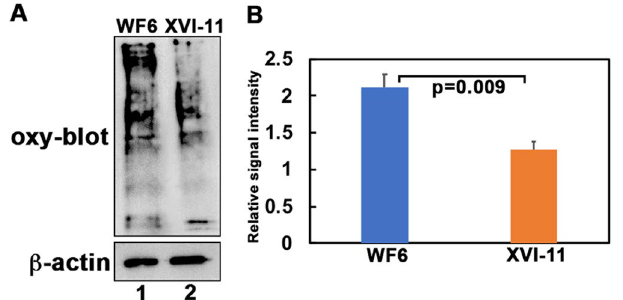
Figure 4. Oxidative damage to MT proteins. ( A ) Protein carbonyl levels were measured with the Oxyblot kit (Millipore). Using mitochondrial protein extracts, the carbonyl groups in the protein side chains were derivatized to 2,4-dinitrophenyl hydrazine (DNP). Western blot analysis was performed with an antibody against DNP. Equal loading was assessed using an anti-β actin antibody (Sigma). Lane 1: MT extract from mixed age populations of WF6 with about equal individuals from ages 1 wk-3 wk of the short-lived WF6 and lane 2: MT extract from mixed age populations of XVI-11 with about equal individuals from ages 1 wk-3 wk of the long-lived XVI-11. ( B ) Bar graph represents the signals obtained from the analysis of the average of 3 blots after normalization to the β-actin bands. Blue corresponds to short-lived WF6 and orange corresponds to the long- lived XVI-11.